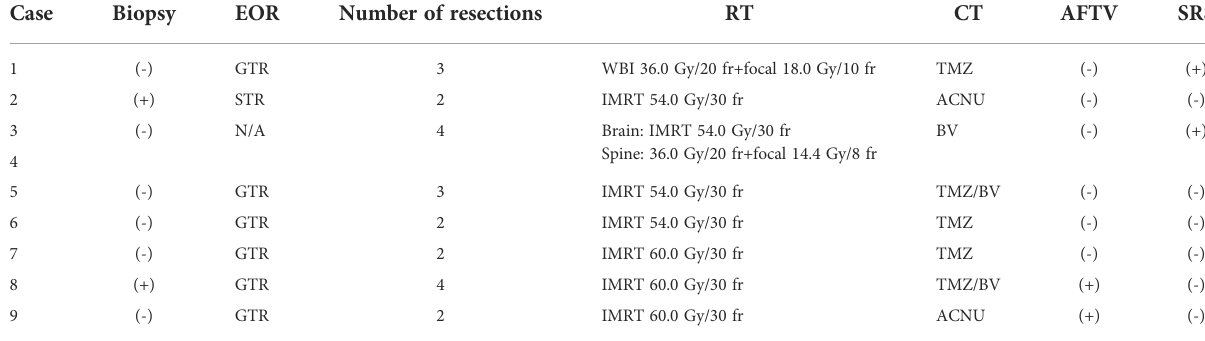
TABLE 2 Treatment modalities and the extent of